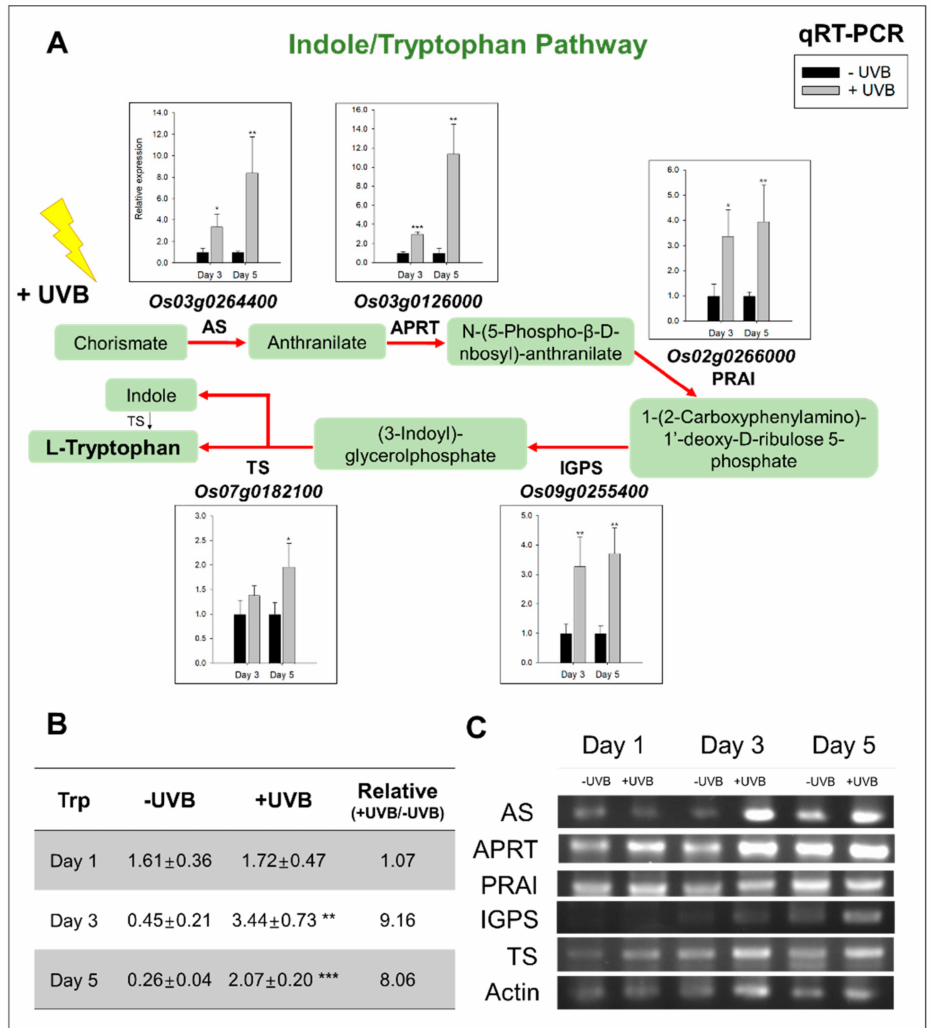
Figure 5. ( A ) Relative expression levels (+UVB/ − UVB) of tryptophan biosynthesis ( A , C )-involved genes by qRT-PCR ( n = 6) and ( B ) the level of tryptophan ( n = 3, peak area by GC–TOFMS) at three timepoints after UVB irradiation. The bars ( A ) in black and grey indicate − UVB and +UVB, respec- tively. Note: *, **, and *** mean p < 0.05, 0.01, and 0.001 (Student’s t -test) for qRT-PCR, respectively. Actin was used as the control. AS, anthranilate synthase; APRT, anthranilate phosphoribosyl trans- ferase, PRAI, phosphor ribosyl anthranilate isomerase; IGPS, indole-3-glycerol phosphate synthase; TS, tryptophan synthase; qRT-PCR, relative quantitative real-time polymerase chain